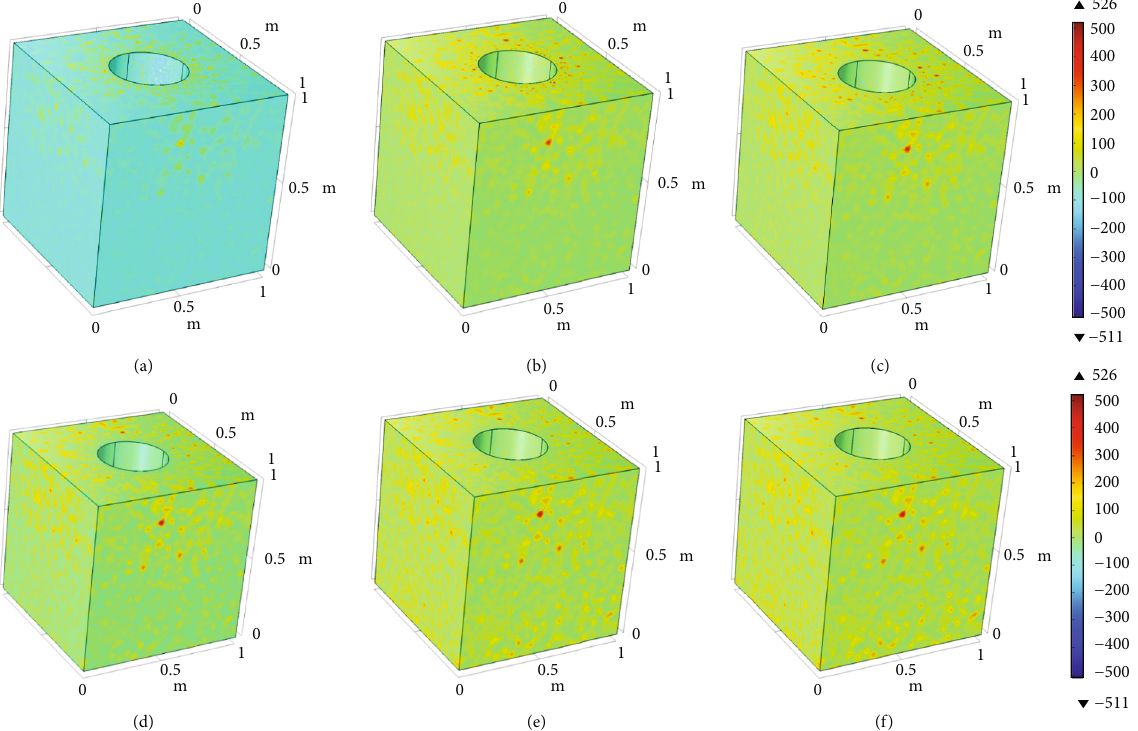
Figure 24: Stress fi eld in the m = 1 coal rock: (a) t = 0 : 1 s, (b) t = 1 × 10 3 s, (c) t = 1 × 10 4 s, (d) t = 1 × 10 5 s, (e) t = 1 × 10 6 s, and (f) t = 4 : 03 × 10 6